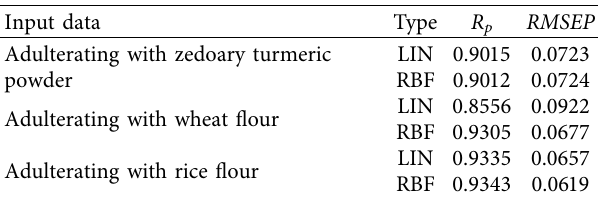
Figure 8: Scatter diagram of LS-SVM prediction model; (a) is scatter diagram of adulterating with zedoary turmeric powder; (b) is scatter diagram of adulterating with rice flour; (c) is scatter diagram of adulterating with wheat flour. Table 2: Prediction results of LS-SVM